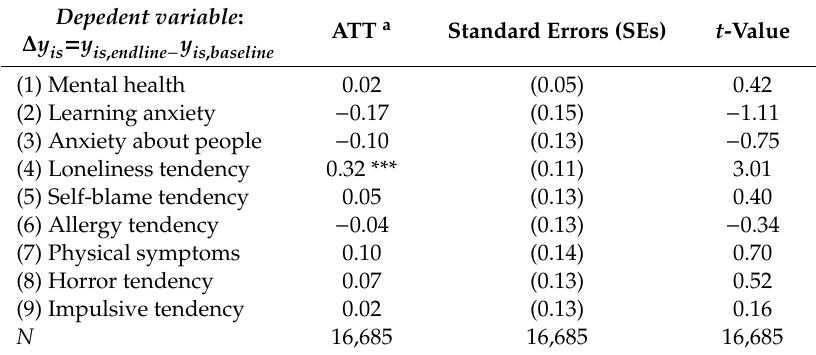
Table 4. The e ff ect of boarding on students’ mental